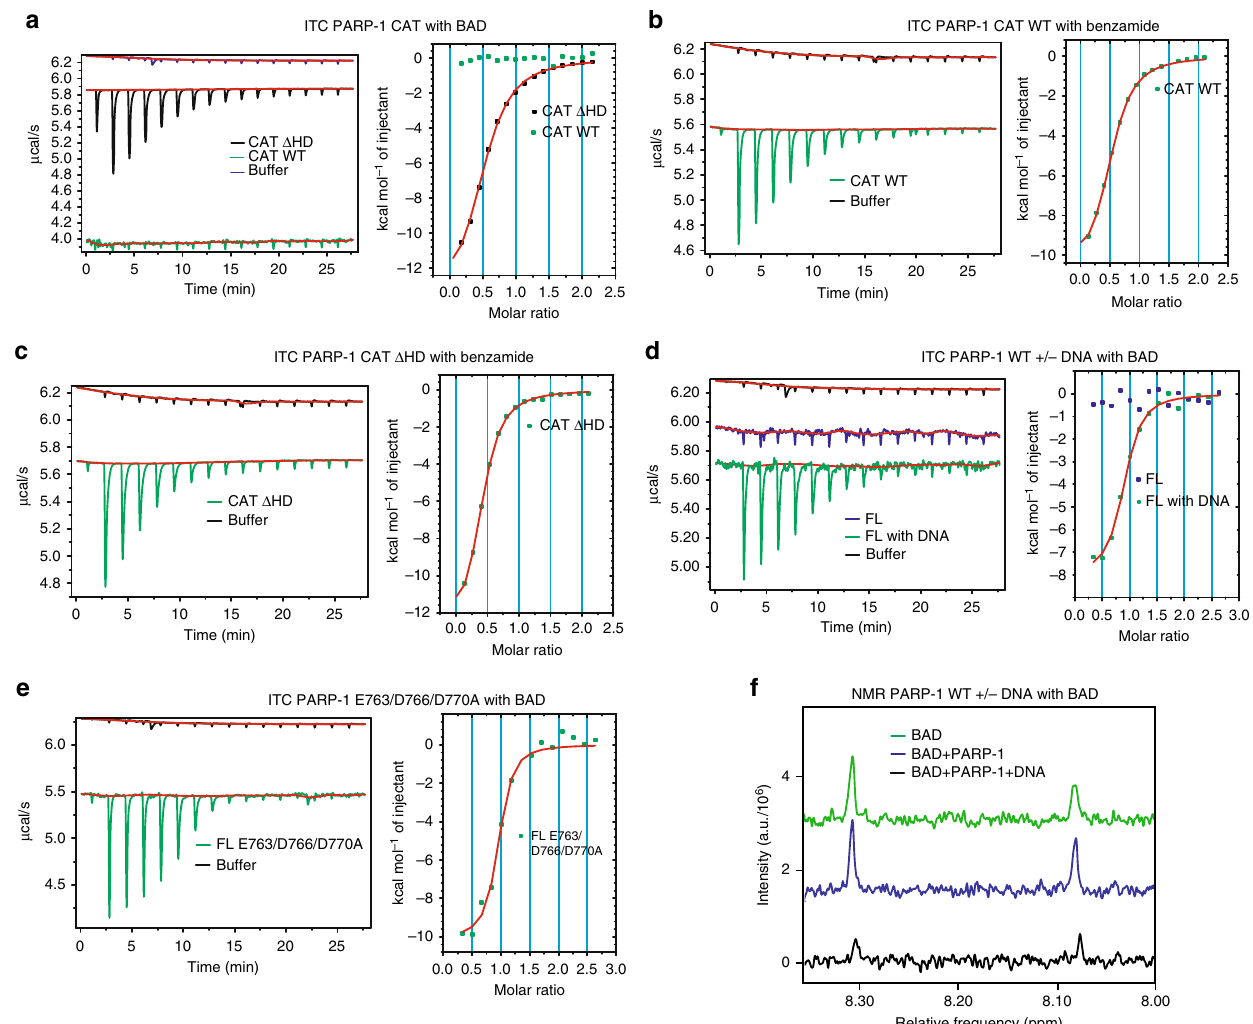
Fig. 4 The autoinhibitory HD blocks NAD + binding to PARP-1. a ITC results where BAD (525 μ M) was titrated into PARP-1 CAT WT and CAT Δ HD, both at 50 μ M. b, c Same as in panel a but performed with benzamide as the titrant. d ITC results where BAD (525 μ M) was titrated into full-length PARP-1 WT (40 μ M) in the absence or presence of DNA (40 μ M, 8 bp-duplex). e ITC results where BAD (525 μ M) was titrated into full-length PARP-1 E763A/E766A/ D770A (40 μ M). f NMR experiment showing the signal obtained for BAD (20 μ M) alone in green, BAD (20 μ M) with PARP-1 (40 μ M) in blue, and BAD (20 μ M) with PARP-1 (40 μ M) and DNA (40 μ M, dumbbell DNA containing a central 1 nt-gap) in black